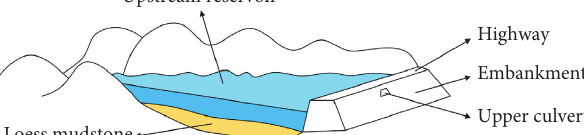
Figure 2: Dam embankment and its upstream